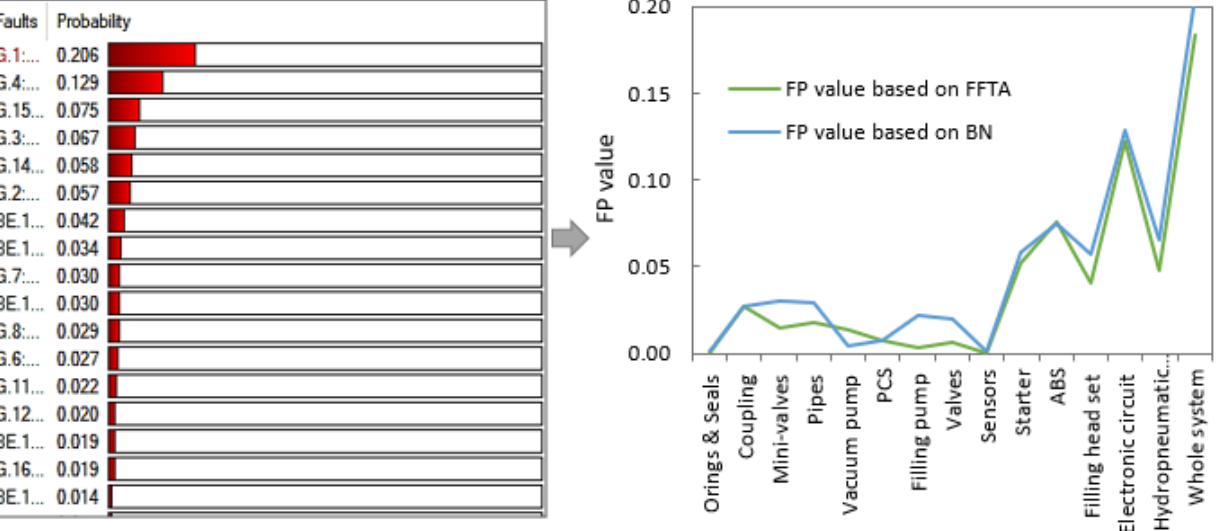
Figure 9. The comparison results of the FFTA and BN models.